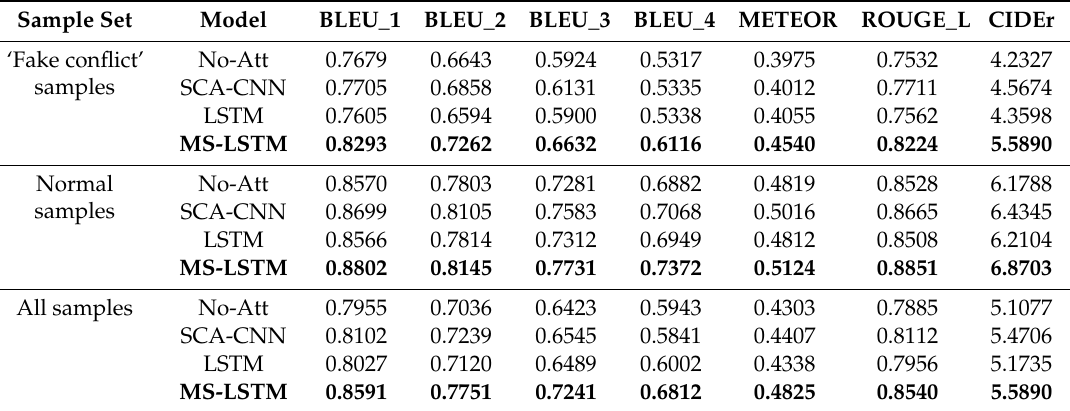
Table 11. Results of each model in comparison experiments.